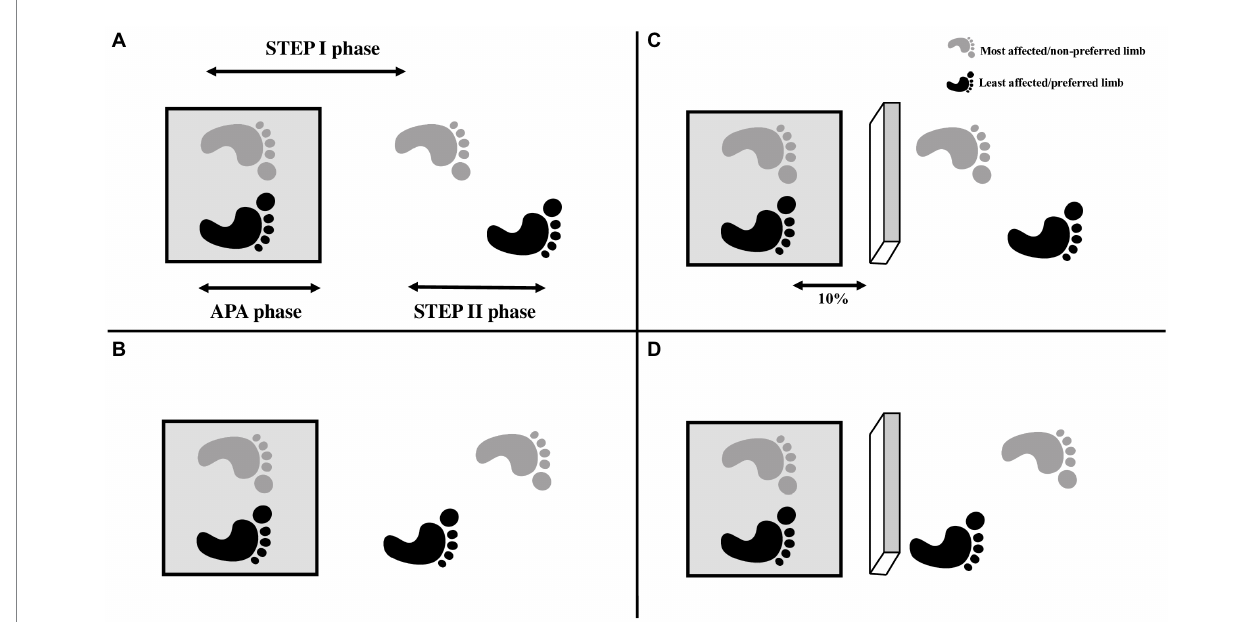
FIGURE 1 Exemplification of the conditions of the GI: (A) GI with the most affected/not preferred limb; (B) GI with the least affected limb/preferred limb; (C) Obstructed GI with the most affected/not preferred limb; (D) Obstructed GI with the least affected/preferred lower limb. The feet were positioned on the force plate (gray square). The arrows in the Figure A represent the phases of GI analyzed: APA phase—defined as the onset of changes in the CoP that occur before any foot apparent movement, based on the displacement and velocity of the heel marker; STEP I phase—the period corresponding to the step performed with the leading foot; STEP II phase—the period corresponding to the step performed with the trailing foot. The 10% in the Figure C represent the distance between participant’s feet and obstacle (10% of the participant’s